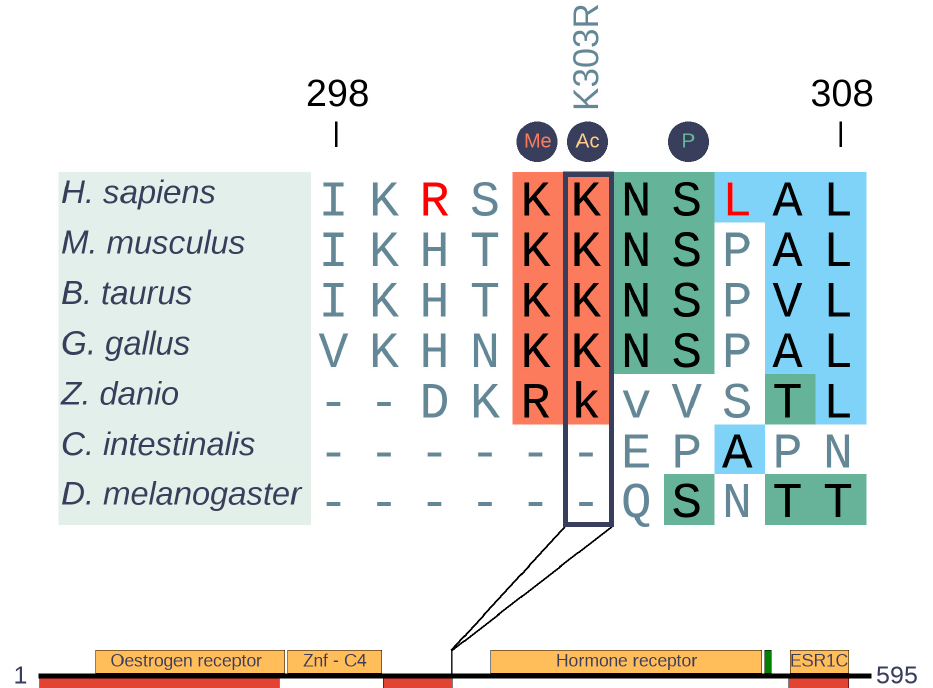
Figure 7. Insertion-free sequence alignment of estrogen receptor 1 (ESR1) orthologs and domain structure of human ESR1. The alignment generated with MAFFT [15] represents the cancer region with sites of post-translational modifications. Borders of non-depicted insertion of zebrafish are indicated by lower case letters. The highly mutated position (K303R) is highlighted by a rectangle. PTM sites are indicated by circles above the alignment. H. sapiens specific changes are colored in red. Domains are depicted in yellow, disordered regions are depicted by red boxes, while the green boxes indicate the cancer risk regions.